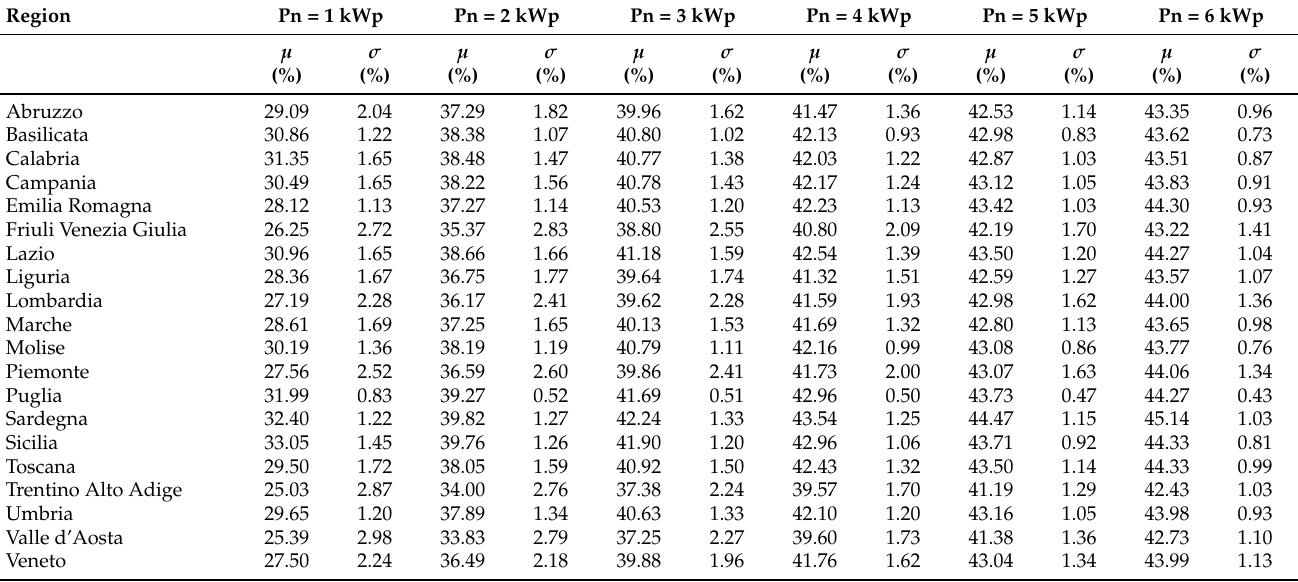
Table 23. Self-Sufficiency for E L = 4000 kWh without